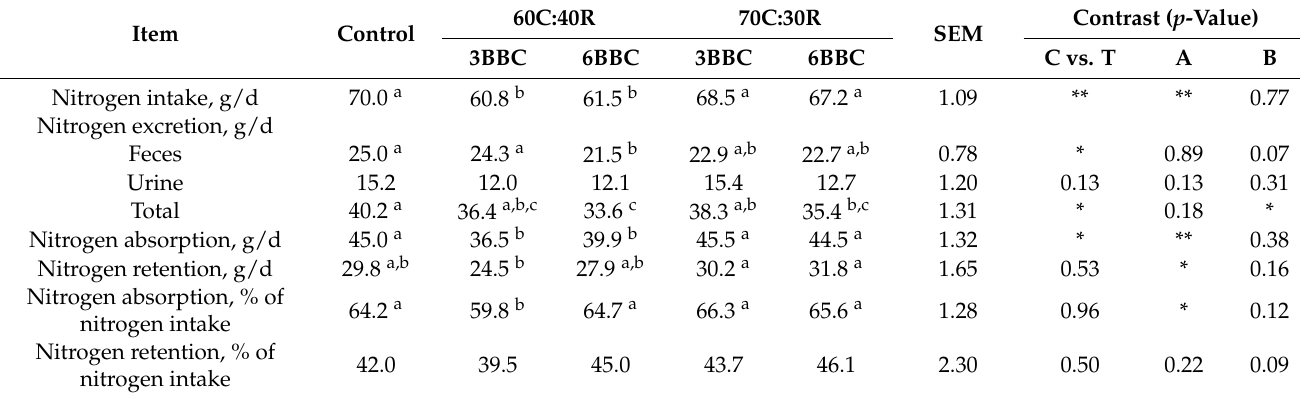
Table 4. Nitrogen balance in beef cattle fed different concentrate-to-roughage ratio diets and different levels of BBC supplementation.